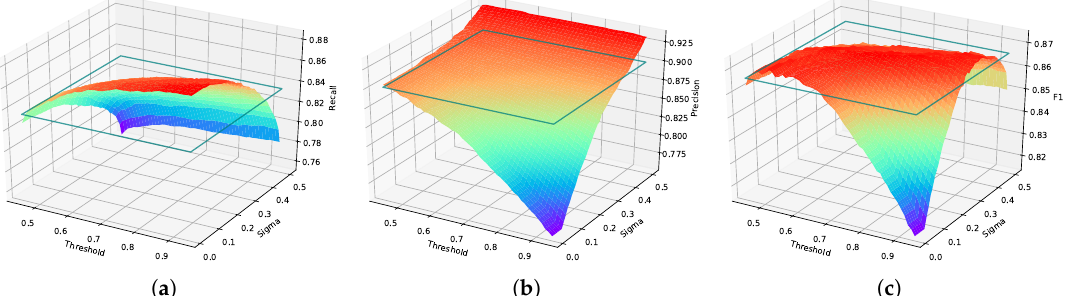
Figure 15. Curved surfaces of detection evaluation standards with Threshold and Sigma as variables. ( a ) curved surface of Recall; ( b ) curved surface of Precision; ( c ) curved surface of F1 score.